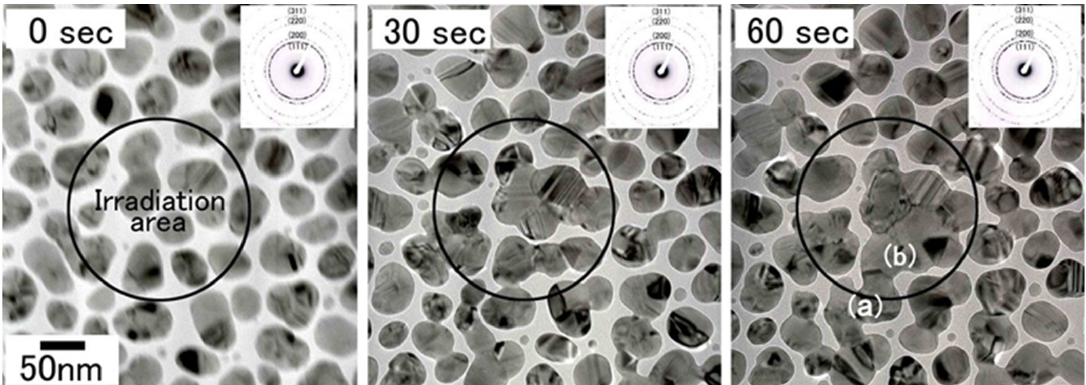
Figure 26. Change of the bright-field images and electron diffraction patterns of Cu nanoparticles irradiated with electrons at an intensity of 5.5 × 10 22 e/cm 2 s for 60 s. Cu nanoparticles migrated to the irradiation centre and bonded with each other in the marked irradiation area. The electron diffraction patterns, typical Cu Debye rings, did not change during irradiation. The nanostructures of the bonded interface (i.e., CSL) boundary, were obtained in regions ( a ) and ( b ) after 60 s of irradiation, as shown in Figure 27 [20].